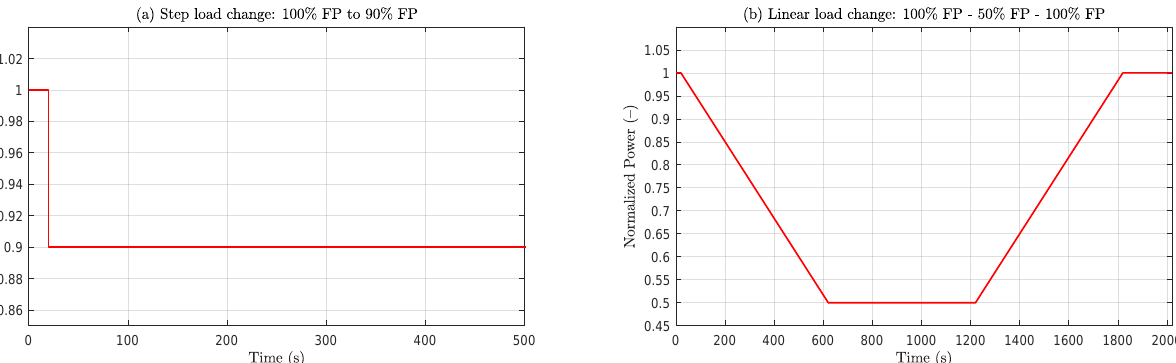
Figure 11. Two benchmark cases: ( a ) step load change: 100% FP to 90% FP; ( b ) linear load change: 100% FP to 50% FP to 100%